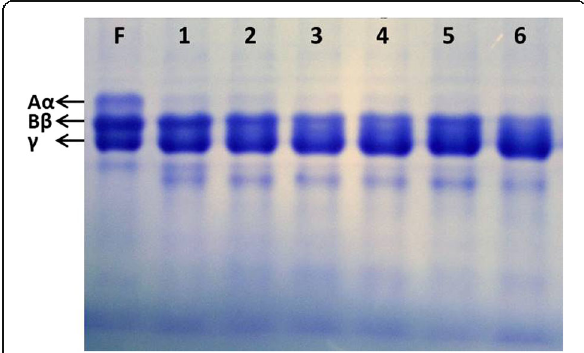
Fig. 2 Fibrinogenolysis by protein fractions of peak P-A: F is fibrinogen which served as negative control; lanes 1 to 6 are protein fractions comprising peak P-A incubated with fibrinogen at 37 °C for 5 h. All fractions of protein peak P-A lysed fibrinogen as seen as disappearance of the A α chain in lanes 1 to 6